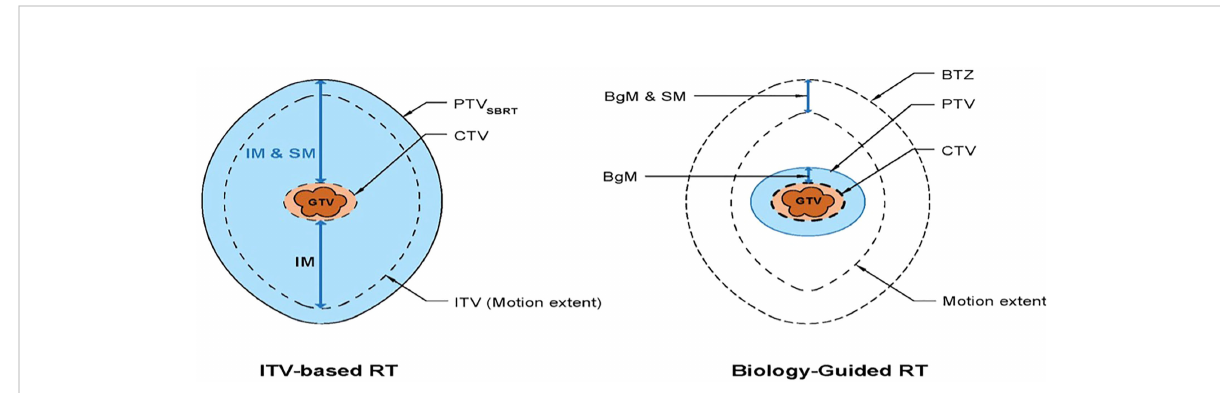
FIGURE 2 Schematic diagram showing the standard RT volumes (left) versus the BgRT volumes (8). IM, internal margin; SM, setup margin; BgM, biology- guided margin; BTZ, biology-tracking